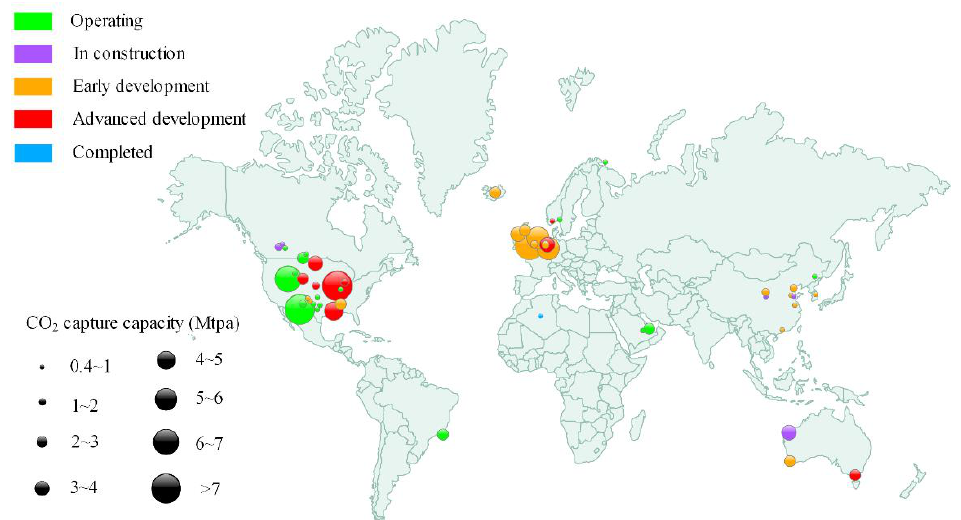
Figure 3. Commercial-scale integrated carbon capture and storage (CCS) projects around the world. Circle size is proportional to the CO 2 capture capacity, and the color indicates different stages of the lifecycle of the project (data from [10]).